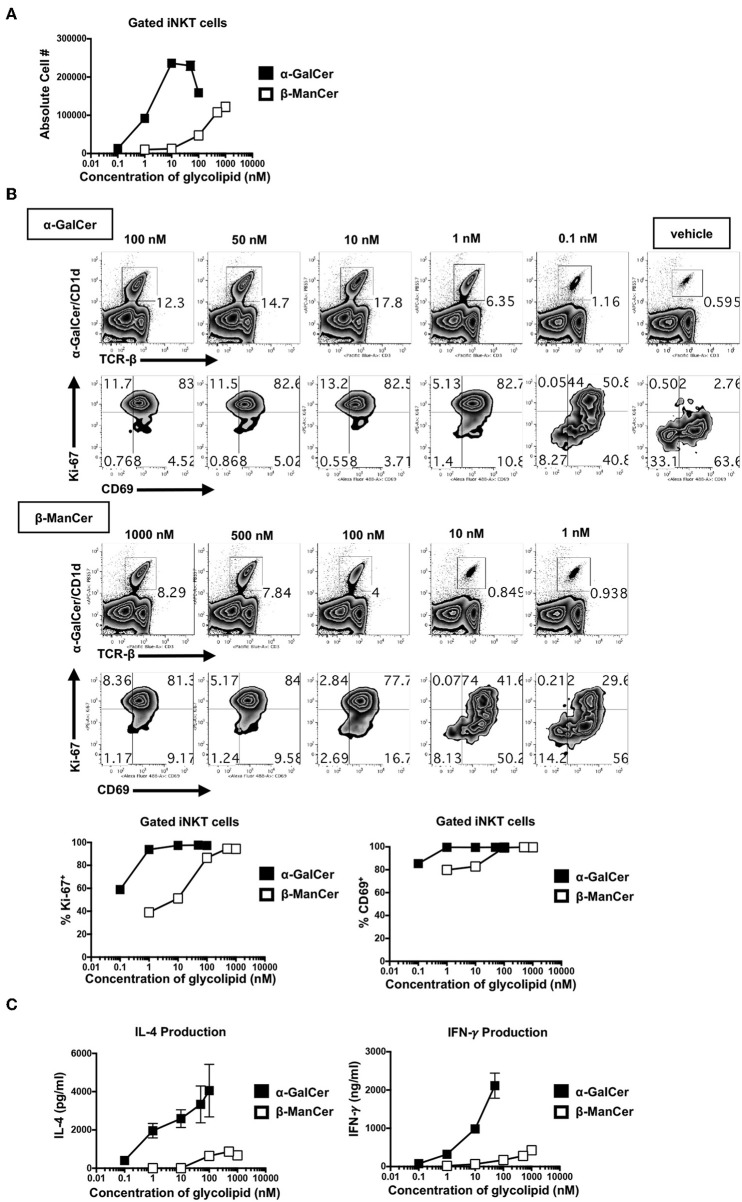
α-GalCer is 100-fold more potent than β-ManCer, inducing Ki-67 and CD69 upregulation and increased cytokine production at lower stimulatory concentrations. (A) Mouse splenocytes were stimulated with vehicle or decreasing concentrations of serially-diluted α-GalCer or β-ManCer for 3 days. iNKT cells were identified as TCRβ (or CD3)intPBS57-CD1d tetramer+ using flow cytometry and were enumerated with CountBright Absolute Counting Beads. (B) iNKT cells, gated as in A, were examined for intranuclear upregulation of Ki-67 or expression of CD69 on the cell surface. (C) Concentrations of IFN-γ and IL-4 in the supernatant were determined by ELISA. Data are plotted as mean ± range of duplicates (A–C). Representative experiments of 2 independent repeats are shown (A–C).